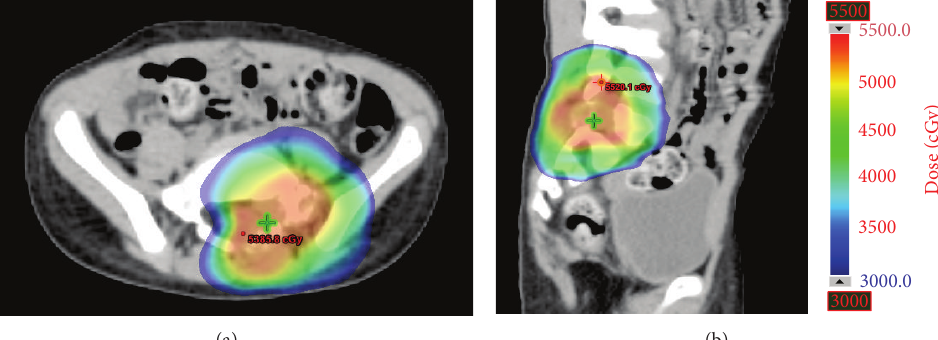
Figure 2: Isodose curves. Axial (a) and sagittal (b) representative isodose curves from the treatment plan used for the osteosarcoma lesion depicted in Figure 1.